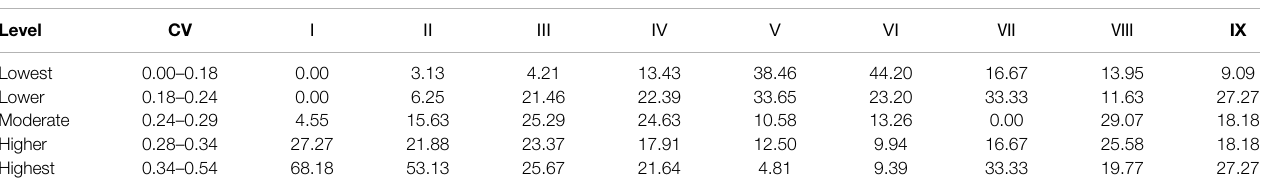
TABLE 2 | Percentage of counties at each level of CV to total counties in corresponding agricultural